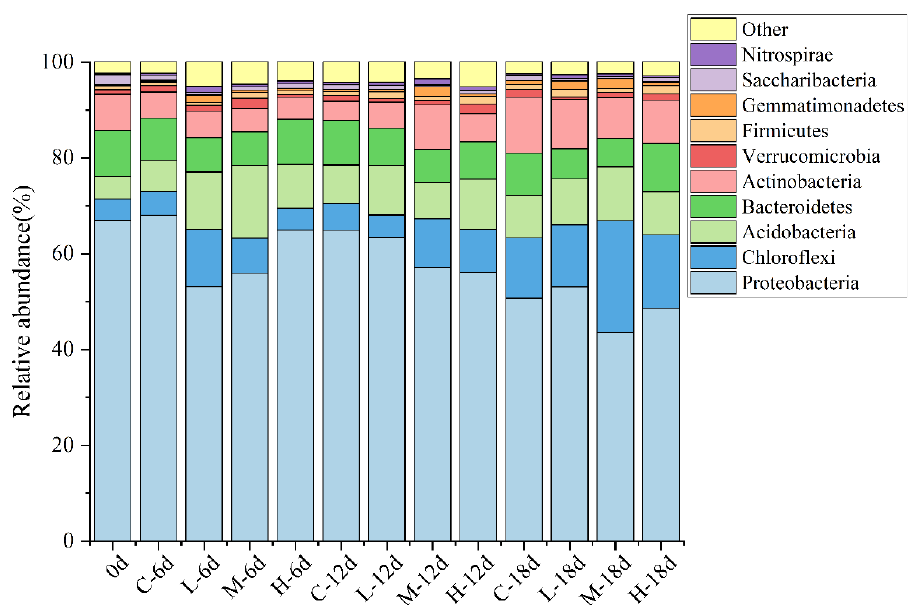
Figure 2. Relative abundance of bacteria communities at the phylum level under different times. C: the sediment with no paroxetine added; L: 10 μg/L paroxetine; M: 100 μg/L paroxetine; H: 1000 μg/L paroxetine.